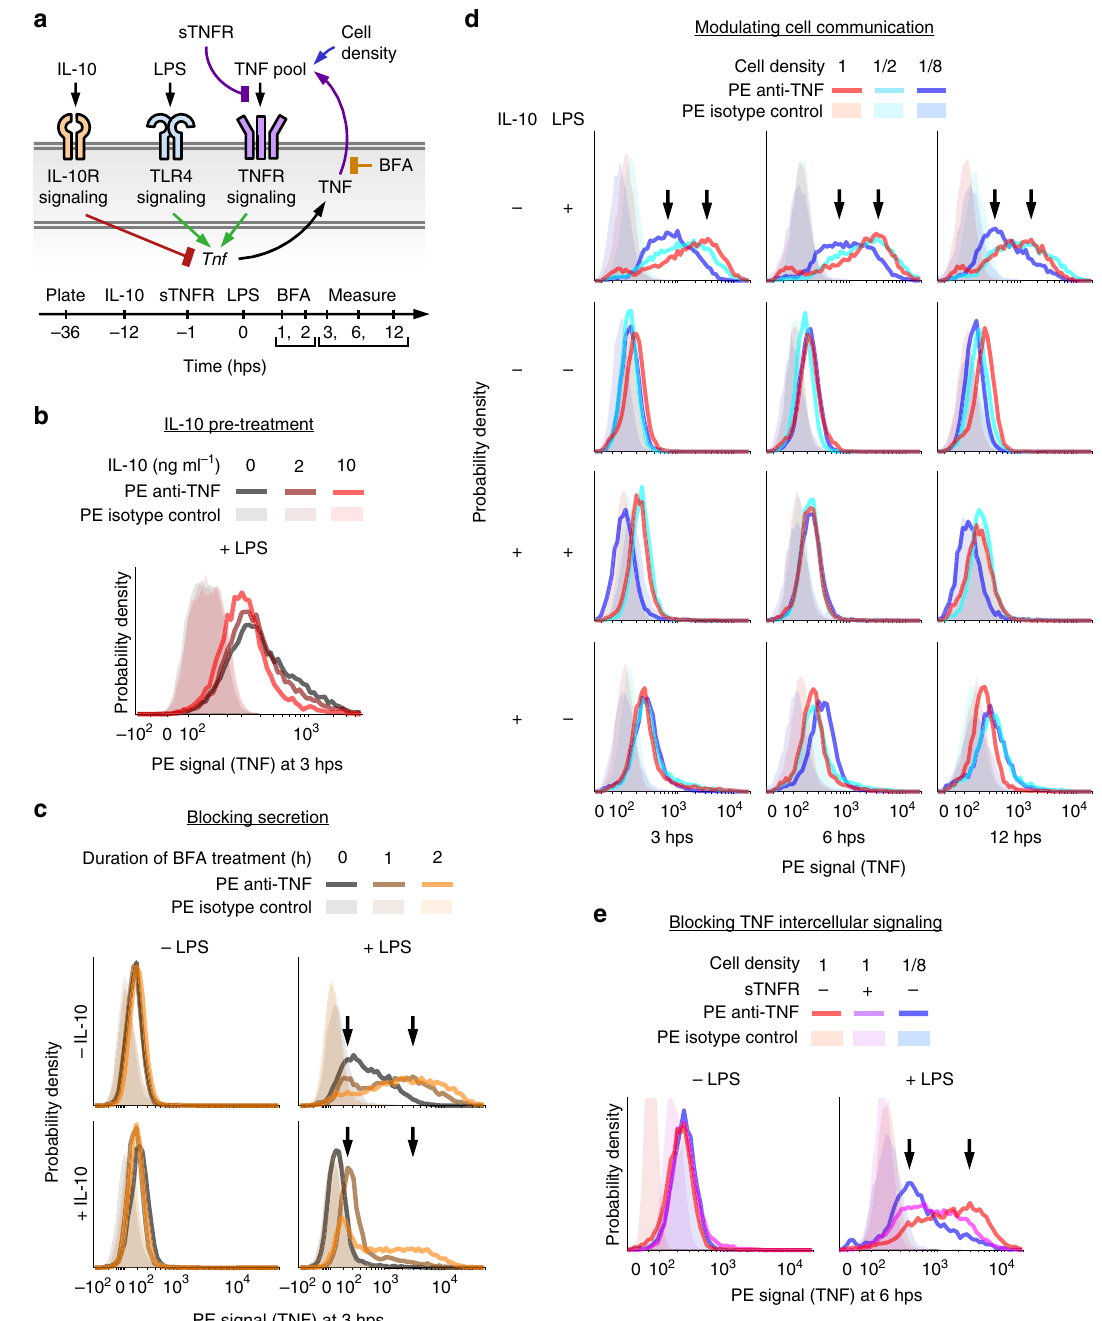
Fig. 1 The TNF response to LPS is heterogeneous and requires intercellular communication. a The diagram summarizes the perturbations and stimuli applied to investigate TNF expression and intercellular communication (hps, hours post-stimulation with LPS). LPS activates TLR4 signaling, which induces TNF expression. IL-10 pretreatment activates IL-10R signaling, which inhibits LPS-induced TNF expression. Secreted TNF activates TNFR signaling, which induces TNF further through intercellular feedback. BFA prevents secretion, causing TNF to accumulate intracellularly. Varying the cell density modulates the concentrations of secreted factors such as TNF. sTNFR binds extracellular TNF and prevents TNFR signaling. b IL-10 pretreatment diminishes LPS- induced TNF expression. c TNF expression is heterogeneous with high-expressing and low-expressing subpopulations. After pretreatment with IL-10 (10 ng ml – 1 ) and/or treatment with LPS (100 ng ml – 1 ), cells were treated with BFA for 1 or 2 h. Arrows in c – e indicate low and high modes of the TNF distributions. d The full TNF response to LPS requires intercellular communication. e Intercellular feedback through secreted TNF is necessary for the full response. Source data are provided as a Source Data fi